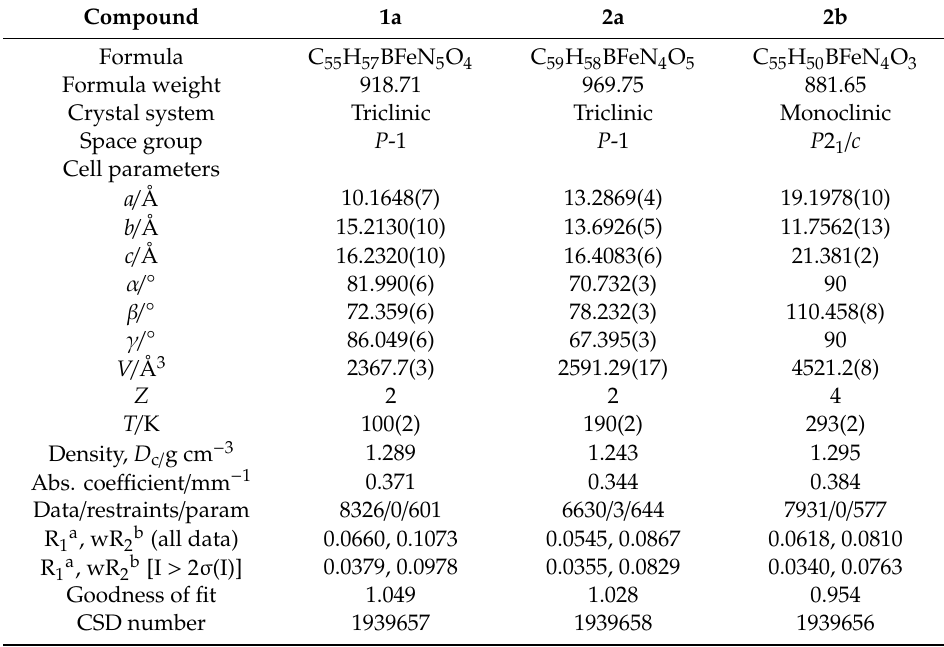
Table 1. Crystal data and details of structure